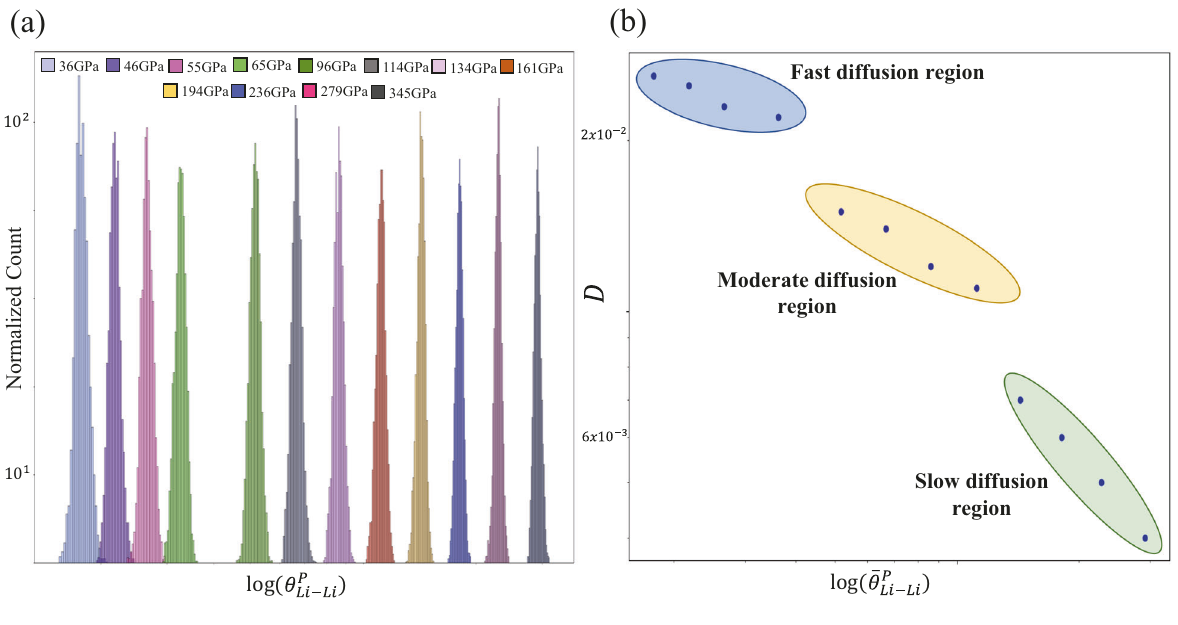
Fig. 3 Characterization of liquid Li using SGOP. a Histograms representing the distribution in SGOP values for each liquid phase of lithium. Colors represent the different phases and are de fi ned in the plot by the external pressure on the simulation box obtained from DFT. b Self- diffusion constant values, obtained from the mean squared displacement of the ab initio molecular dynamics trajectories plotted as a function of the mean of each histogram, shown in ( a ). Three diffusion regions are highlighted and are determined by the underlying structure of the vibrational density of states of each trajectory, calculated from the velocity auto-correlation function. θ P is de fi ned as the SGOP for a speci fi c phase